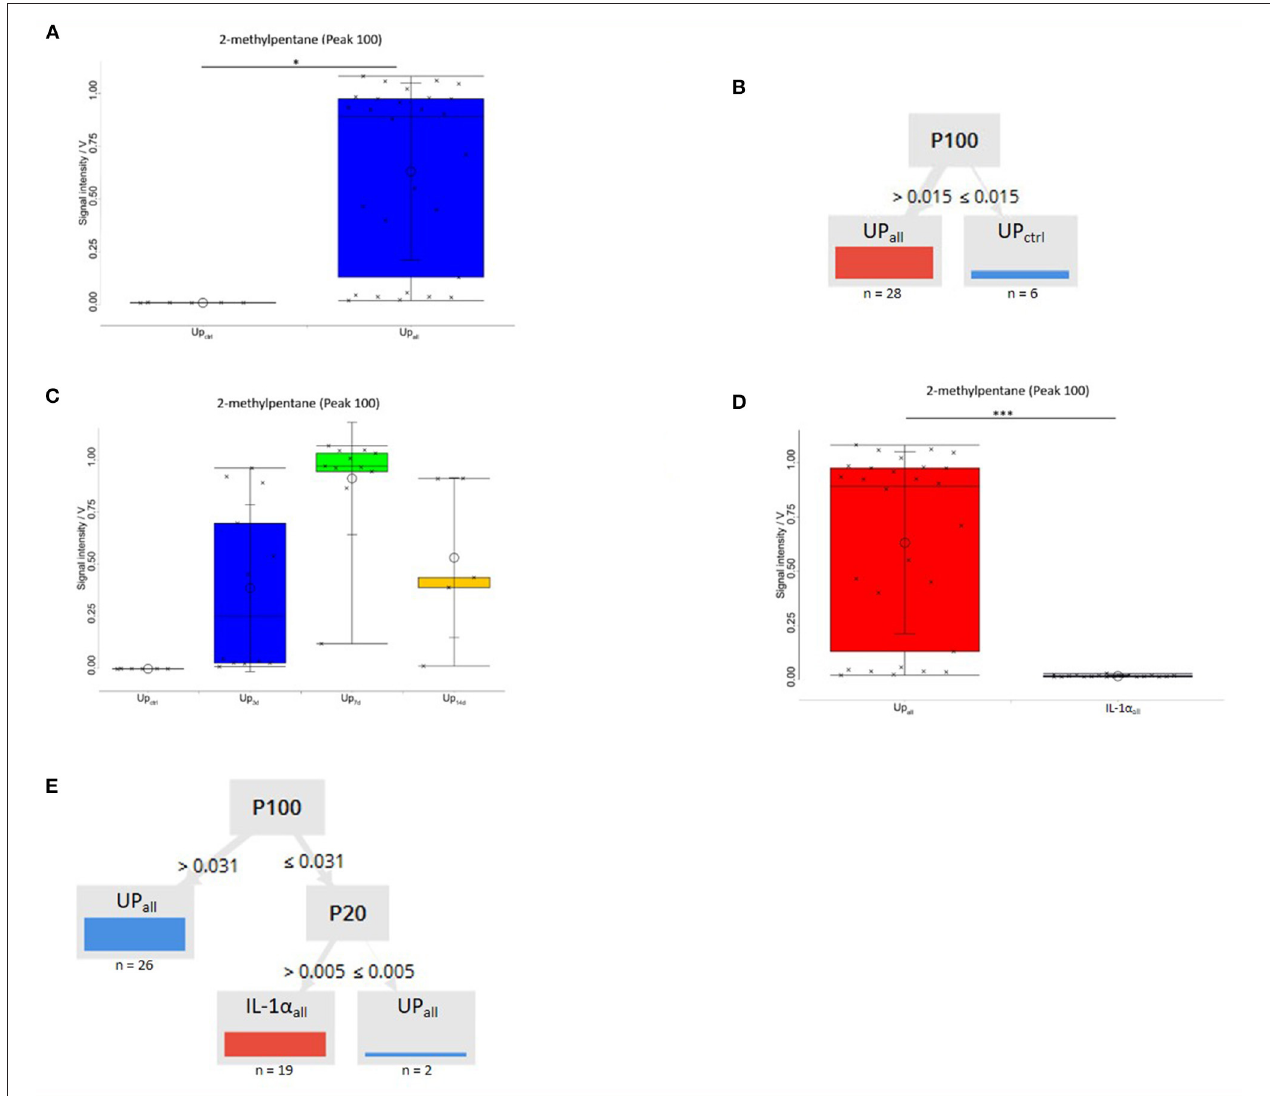
FIGURE 3 | Box-and-Whisker Plot of peak 100 (2-methylpentane) of all samples medium vs. all samples Up. (A) 2-methylpentane was significantly higher in Up all samples vs. all samples medium control (Up ctrl n = 6, Up all n = 28). Sensitivity/specificity was 100/100% with positive predictive value/negative predictive value 100/100%. Measurements are marked with crosses. Significance levels after Bonferroni correction are indicated ( p < 0.05). (B) A decision tree based on one compounds is shown. Samples are grouped according to the means of the peak intensity of each compound, at which point, the maximum number of samples are classified correctly. Relative numbers of classified all samples medium control (Up ctrl ) are blue, and numbers of classified all samples Up (Up all ) are red. Discrimination of the two groups is possible. Sensitivity/specificity was 100.0/100.0% with positive predictive value/negative predictive value 100.0/100.0%. Every measurement was correctly assigned to its class. (C) 2-methylpentane concentrations were significantly elevated compared to controls at 3 days post-infection (Up ctrl n = 6, Up 3d n = 12; Up ctrl vs. Up 3d p < 0.001), appeared to peak at 7 Day post-infection (Up ctrl n = 6, Up 7d n = 11; Up ctrl vs. Up 7d p < 0.001) and then appeared to be declining in intensity by 14 post-infection (Up ctrl n = 6, Up 14d n = 5; Up ctrl vs. Up 14d p < 0.01). Sensitivity/specificity were 100/100% with positive predictive value/negative predictive value 100/100% for each comparison. (D) Box-and-Whisker Plot of best separating peak 100 (2-methylpentane) between Up and IL-1 α . 2-methylpentane was significantly higher in all samples Up vs. all samples IL-1 α (Up all n = 28, IL-1 α n = 19). *** p < 0.001 after Bonferroni correction. (E) Decision tree algorithm to discriminate between all samples Up and all samples IL-1 α . Discrimination of the two groups is possible by using peak 100 (2-methylpentane) and peak 20. * p < 0.05 after Bonferroni correction.